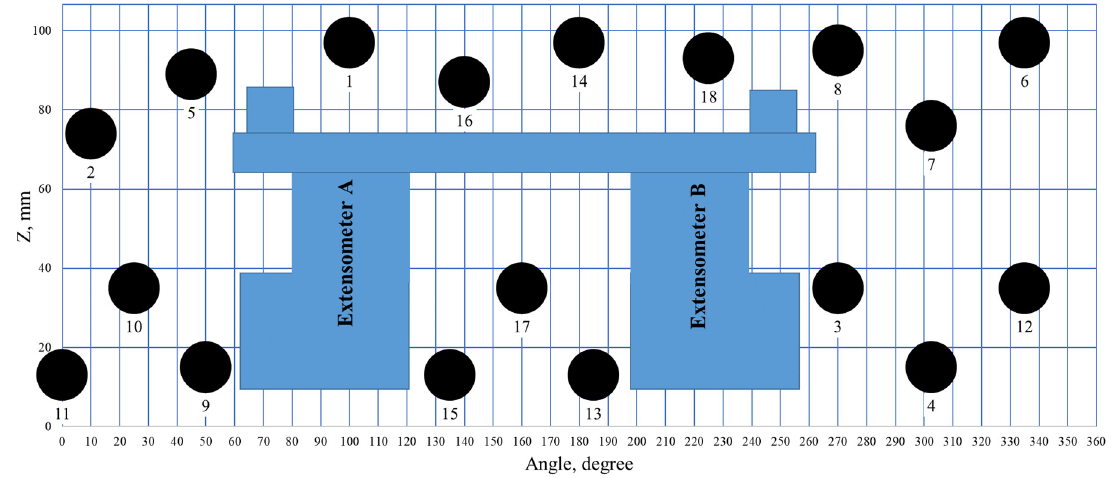
Figure 4. Projected sample surface with positions of 18 AE sensors and the simplified Extensometer as a function of azimuth and vertical coordinate Z.